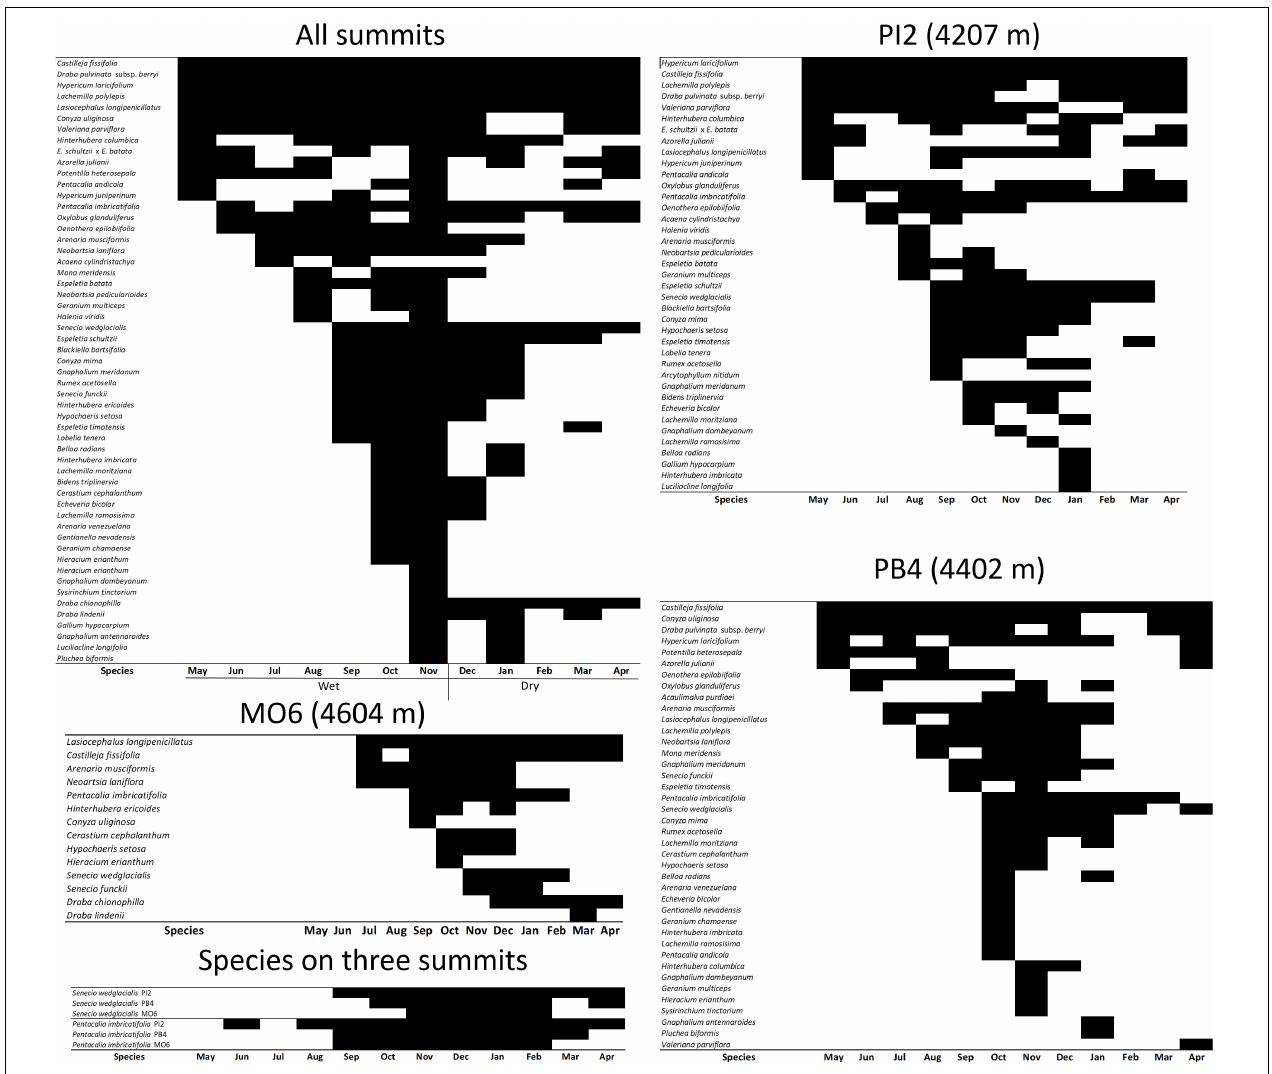
FIGURE 2 | Qualitative phenology (presence in black-absence in white) of flowering of the 43 vascular plant species studied in three summits of the GLORIA–Andes network (VE-CPB site), at La Culata National Park, Piedras Blancas Páramo, Venezuela. Species are ordered first in decreasing order in terms of the duration of flowering, and secondly in terms of the coincidence of flowering with the beginning of the wet season (May).